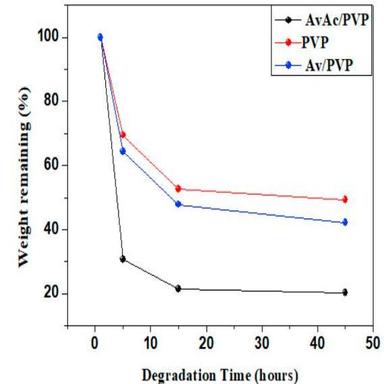
In vitro degradation of electrospun PVP, Av/PVP, AvAc/PVP.